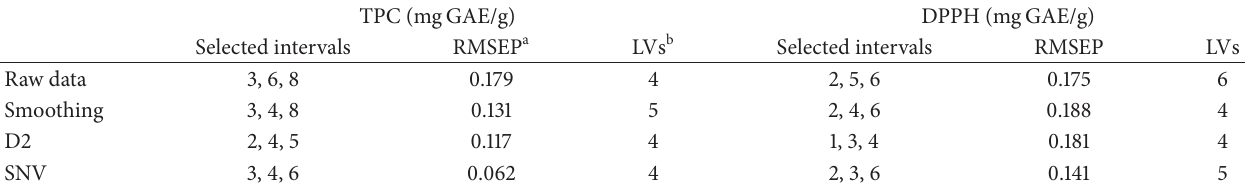
a RMSEP: root mean squared error of prediction by the final iPLS with selected spectral intervals. b Number of components of the final iPLS models including all the selected spectral intervals.